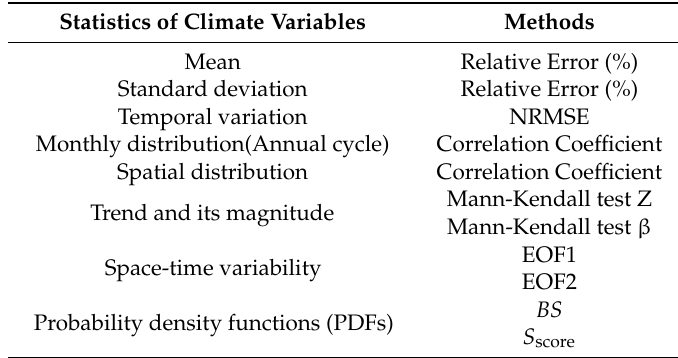
Table 2. Statistics of climate variables used for GCM performance